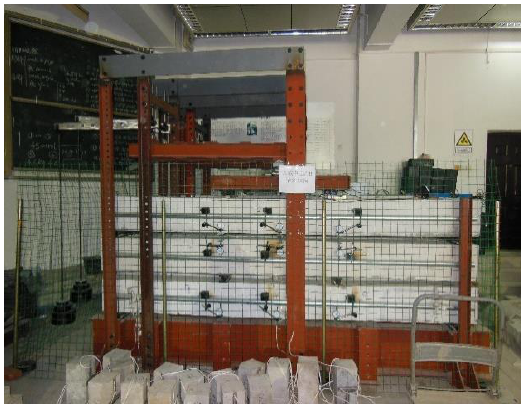
Figure 6. Photo of the experimental test setup.